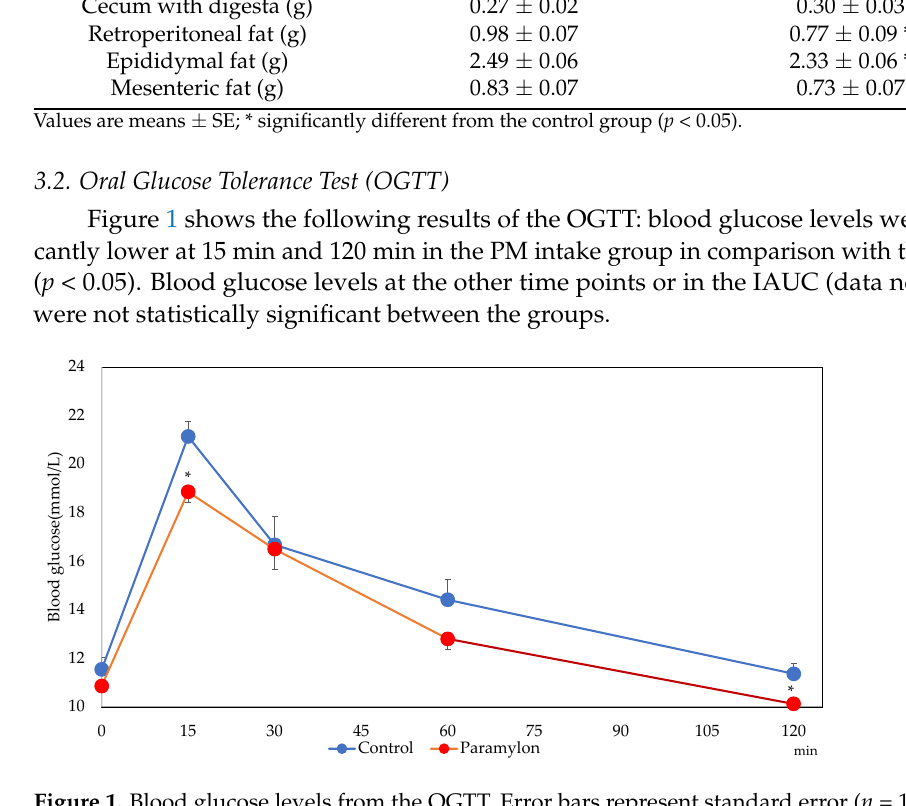
Figure 1. Blood glucose levels from the OGTT. Error bars represent standard error ( n = 10). * Blood glucose levels were significantly lower at 15 min and 120 min in the PM group when compared with the control group ( p < 0.05).